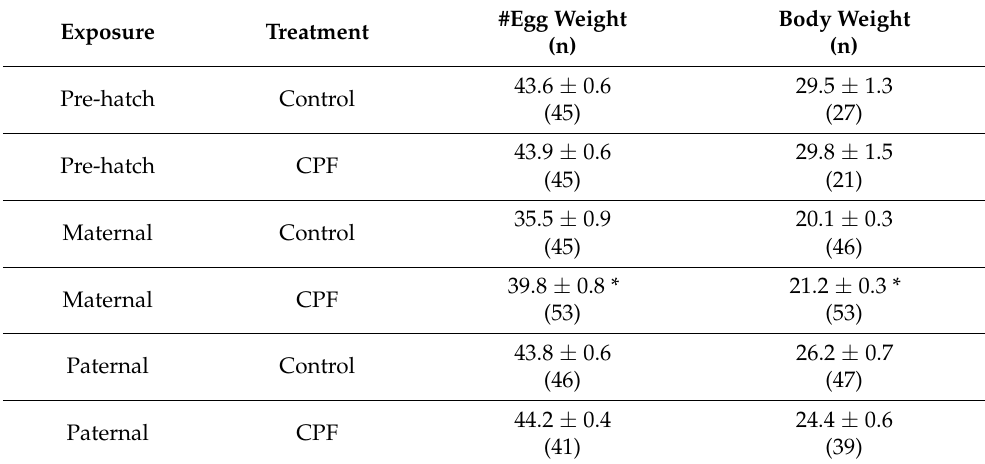
Table 1. Egg weights and offspring’s body weights after pre-hatch, maternal and paternal exposures.